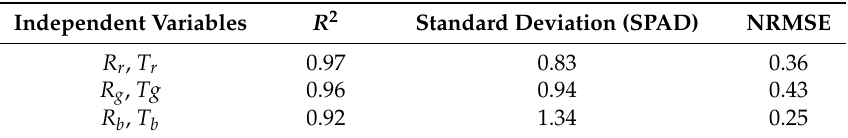
Table 2. Multiple linear regression models (using two